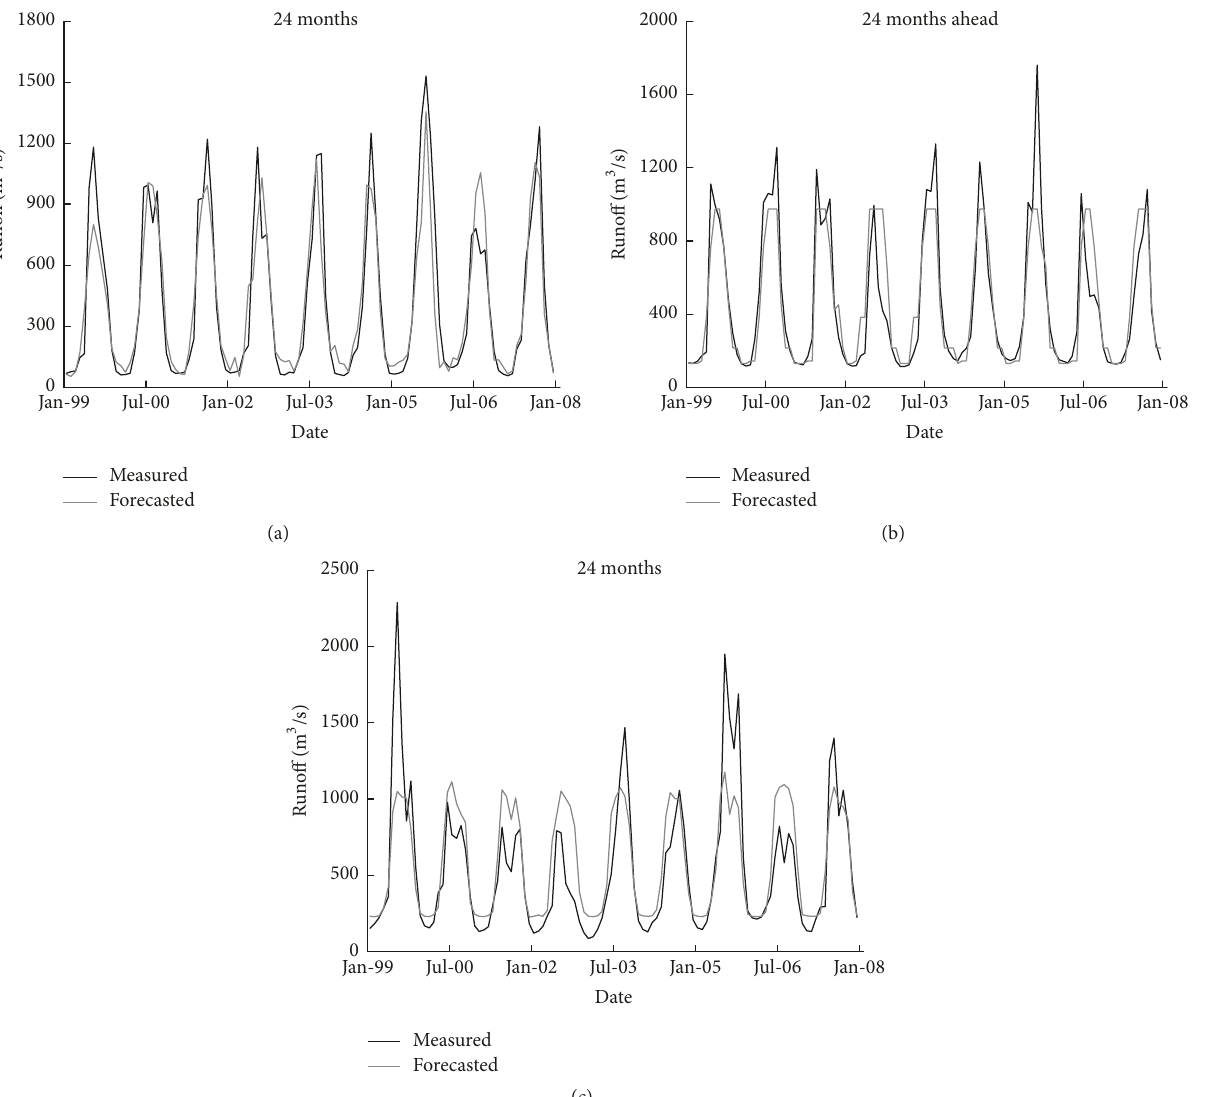
Figure 3: Comparison of the measured runoff values and those forecasted 24 months ahead by the ANN model for the YARHR (a), the LARHR (b), and the YERHR